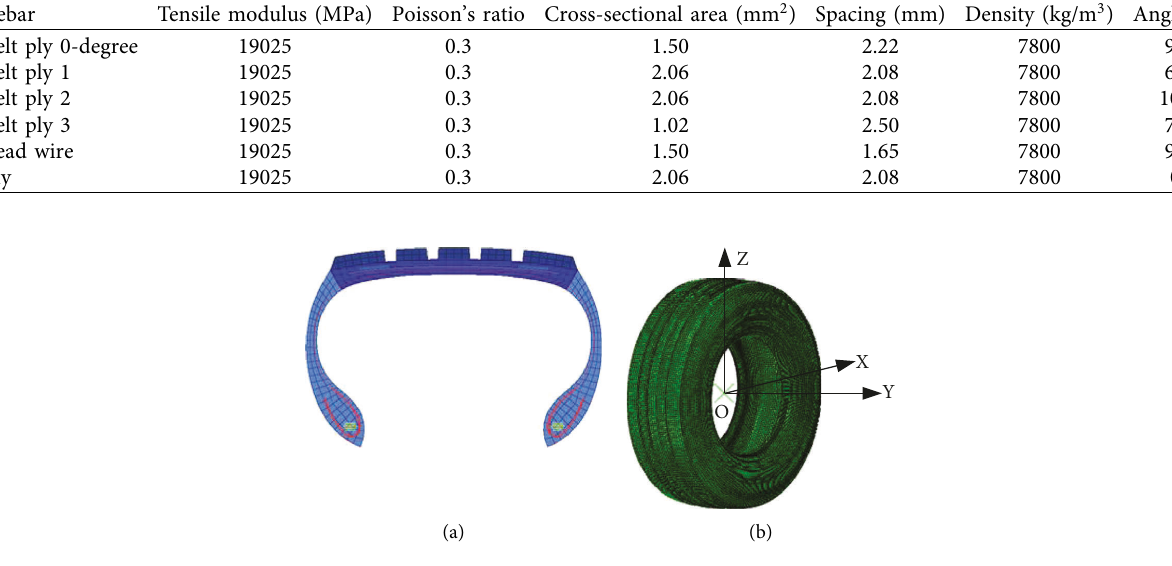
Figure 1: Tire finite element model: (a) 2D and (b) 3D.